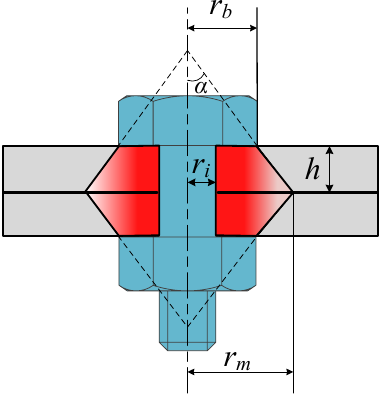
Figure 11. Schematic diagram of pressure distribution in bolted joint.